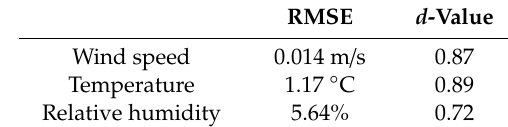
Table 1. The RMSE and d values of model validation.